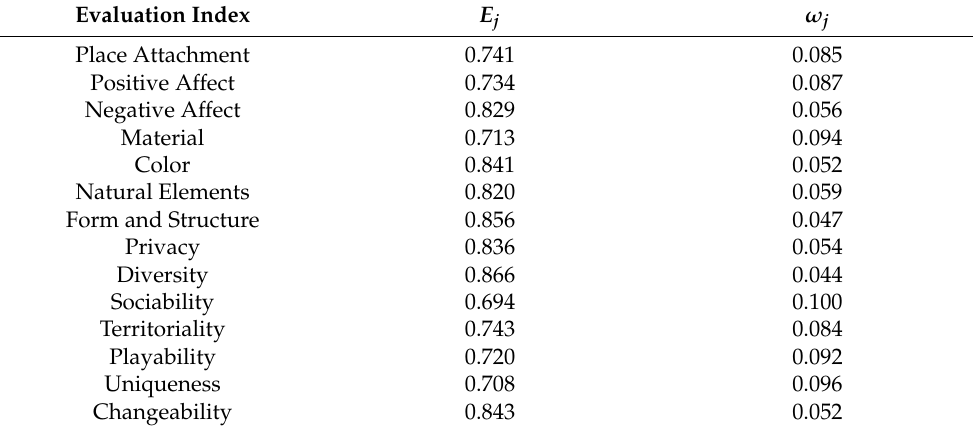
Table 8. Weight of each indicator.